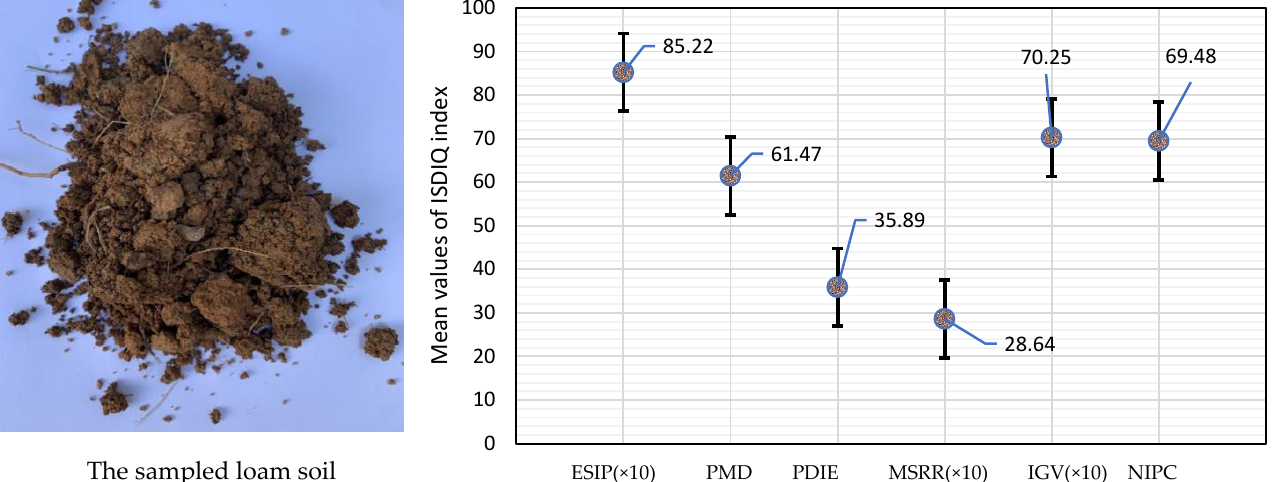
Figure 6. The loam soil specimen and its corresponding SDIQ index values obtained from the sampled layer C.